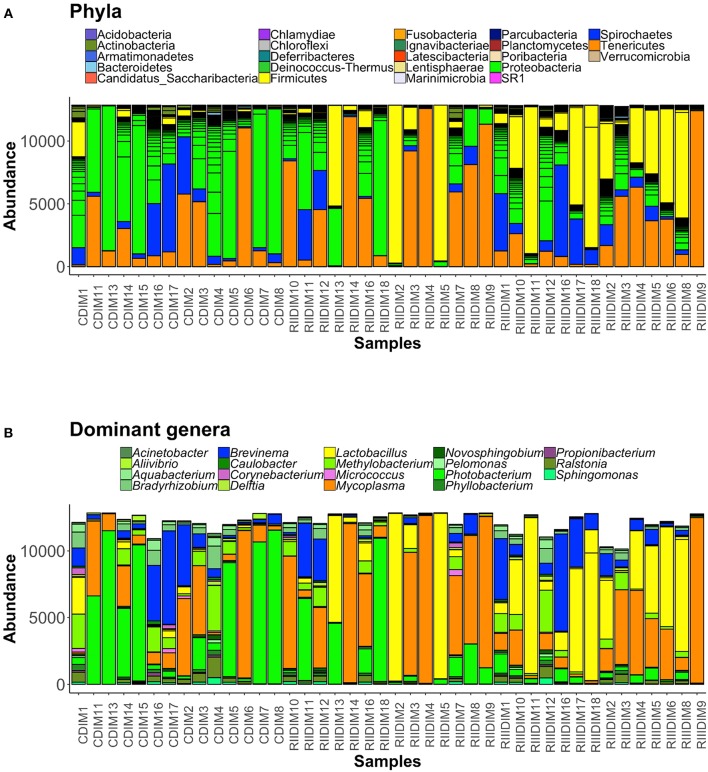
Barplots showing the abundance of all bacterial phyla (A), and dominant genera (B) in the intestinal mucus. The height of each bar segment represents the abundance of individual operational taxonomic units (OTUs) stacked in order from highest to smallest, and separated by a thin black border line. Color codes for the dominant genera: Proteobacteria—shades of green, Spirochaetes—dark blue, Firmicutes—shades of yellow, Actinobacteria—shades of orchid, and Tenericutes—dark orange.